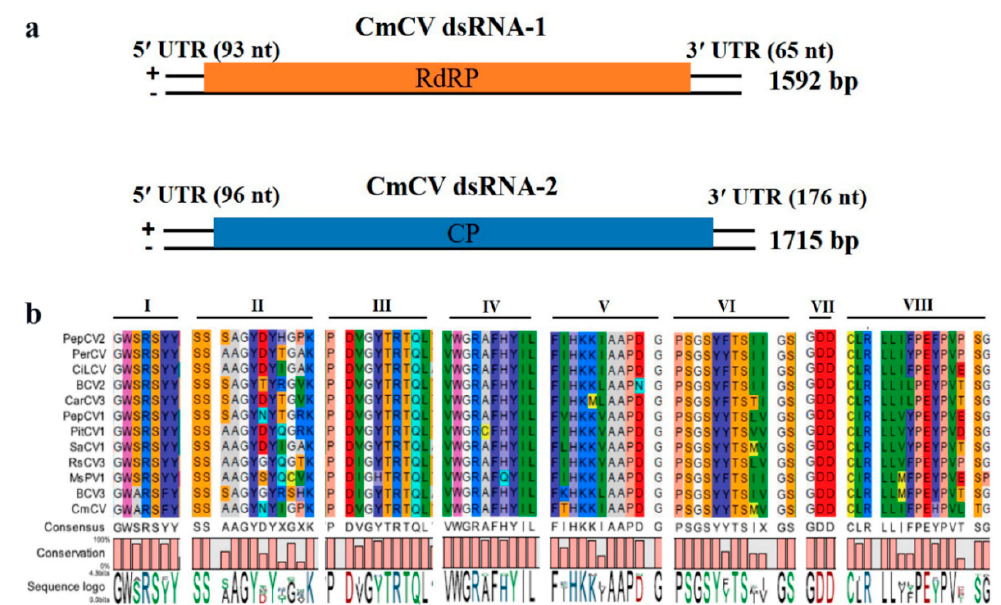
Figure 2. Schematic representation of the genome organizations of Cucumis melo cryptic virus (CmCV) ( a ) and amino acid alignment ( b ) between conserved RNA-dependent RNA polymerase (RdRp) motifs of CmCV and selected proved or putative deltapartitiviruses.